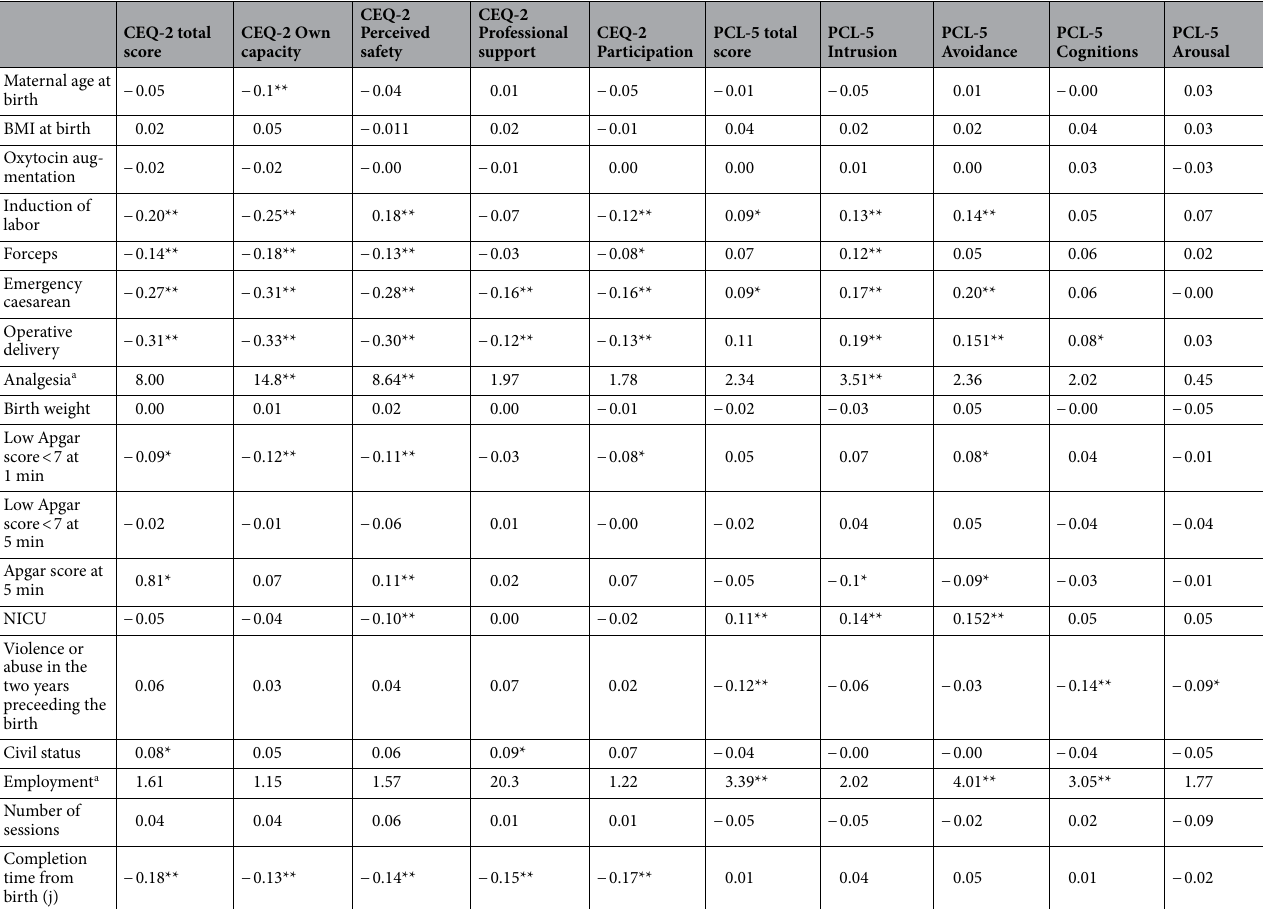
Table 3. Bivariate Pearson correlations between the dependent variables (PCL-5, CEQ-2) and sociodemographic, as well as obstetric and neonatal variables. a One-way ANOVA. * p < 0.05; ** p <